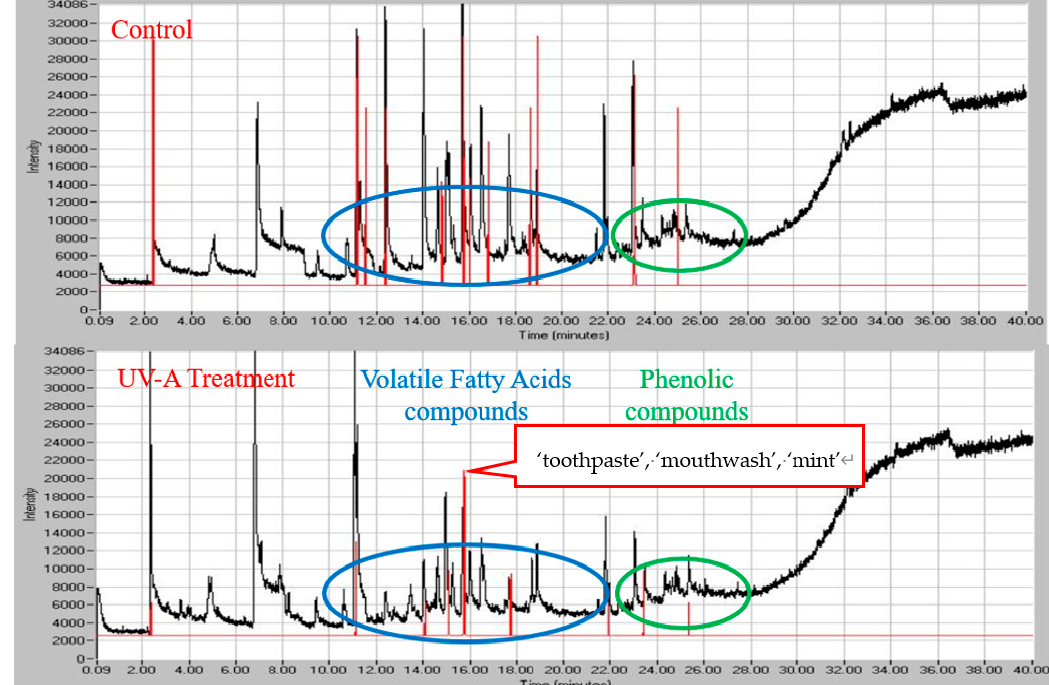
Figure 3. An overlay of the chromatogram (black line) and aromagram (red line). The height of aromagram peaks represents measured odor intensity (percent relative scale). The TIC signal is collected simultaneously, enables linking odors to specific chemicals in the mixture. Several unpleasant (out of 31 total) odors with medium-to-strong intensity were recorded during analysis with GC-MS-O. The ‘toothpaste’, ‘mouthwash’, ‘mint’ scents are emerging in UV-A treated